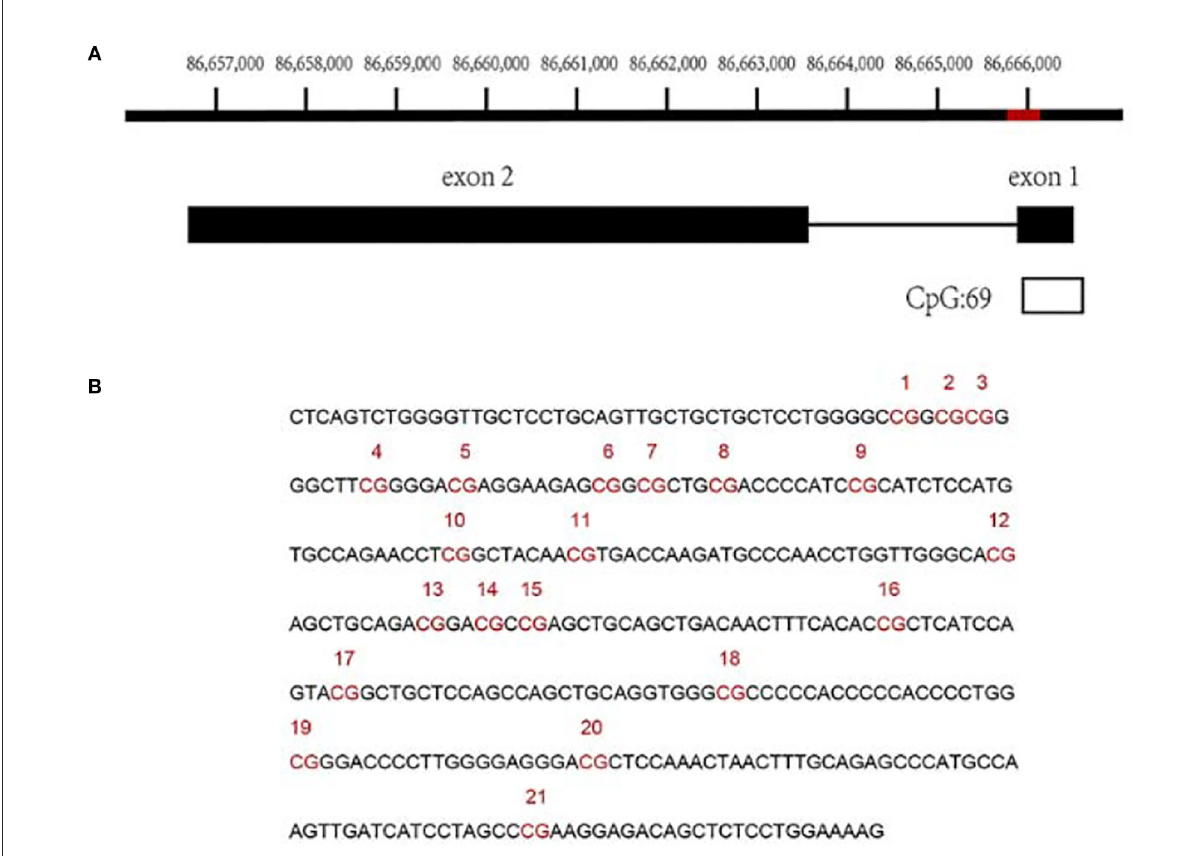
FIGURE2 Analysis of methylation of CpG sites in the FZD4 exon 1 region. (A) The red region showed the location of tested sequence. The black box showed FZD4, black line indicated intergenic region and the white box indicated the CpG island region (CpG: 69) located in the exon 1 region of FZD4. (B) The sequence and CpG sites analyzed in this study were presented. The CpG sites were numbered and indicated as